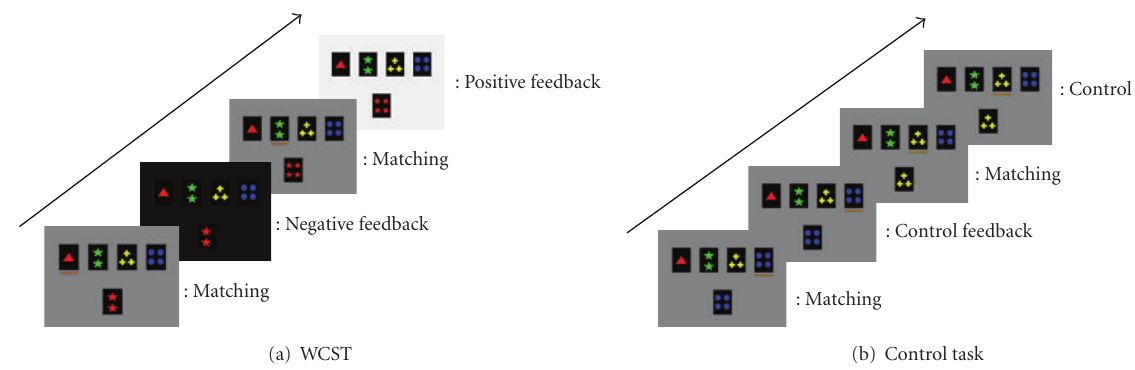
Figure 3: Behavioral tasks. (a) WCST: the four cards shown on the top in the computer screen are reference cards, and the card on the bottom is the test card. The subjects could move a yellow bar which was displayed under the reference cards by pressing the left button of a mouse with their index finger. Pressing the right button with the middle finger confirmed the selection of the card followed by negative or positive feedback. The subjects had to find out the rule of classification (color, shape, and number) by trial and error. (b) Control task: the test card was identical to one of the reference cards. The rest was the same as WCST.